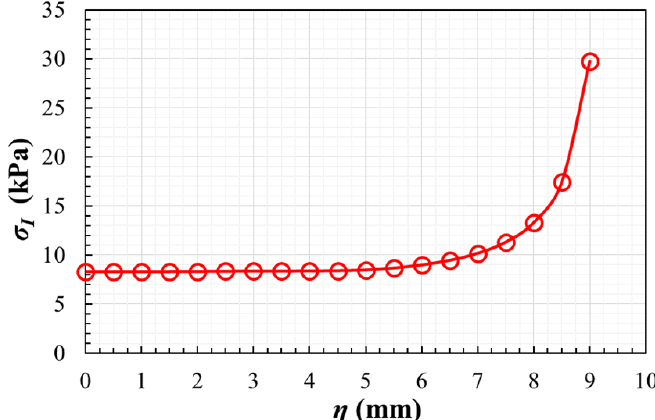
Figure 10. In geometry B, the maximum principal stresses along the path for fillet radii R e = 1 mm and R i = 1.6 mm.